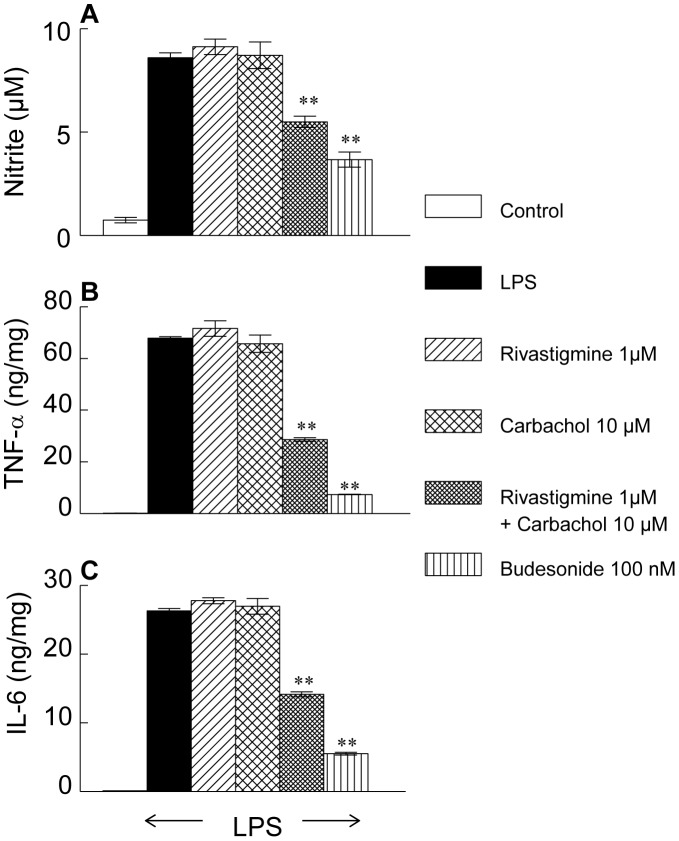
Effect of rivastigmine and carbachol on the release of NO and pro-inflammatory cytokines in macrophages.Data represent the mean ± SEM of 3 independent experiments performed in triplicates. Significantly different from LPS alone, **p<0.01.